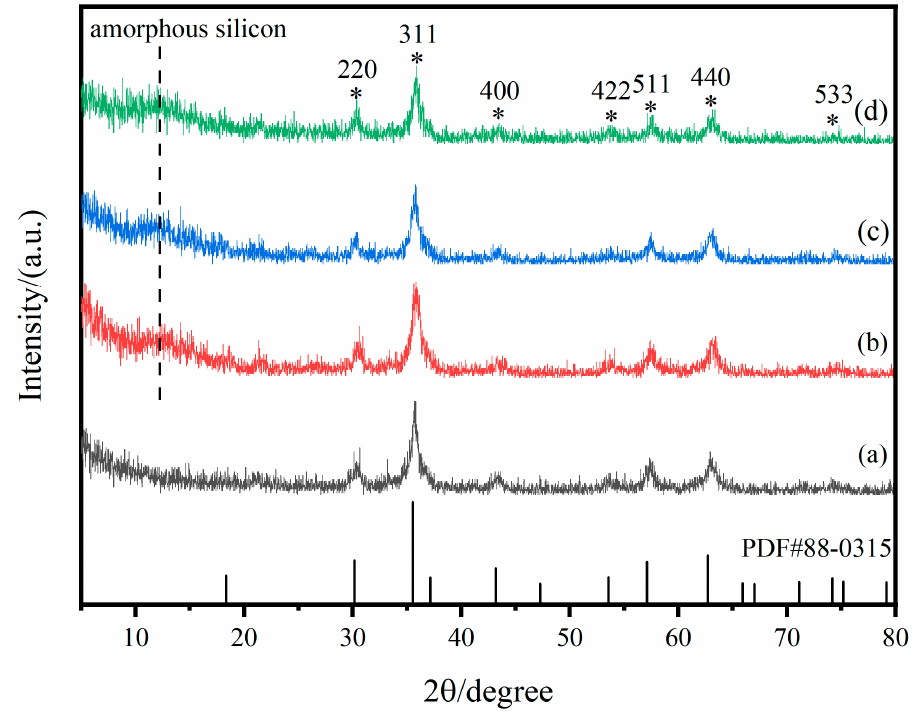
Figure 5. Wide-angle XRD spectra of ( a ) Fe 3 O 4 , ( b ) Fe 3 O 4 @SiO 2 , ( c ) Fe 3 O 4 @SiO 2 -PrSO 3 H and ( d